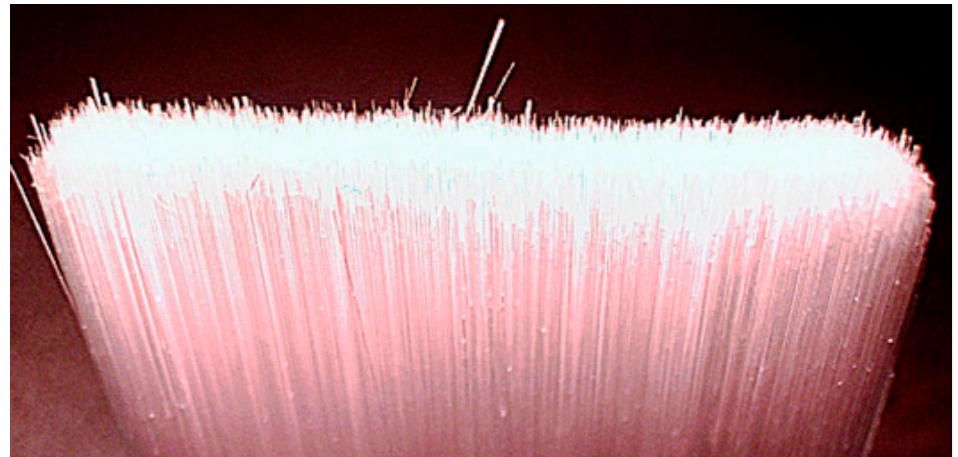
Figure 1. A bundle of sapphire fibres obtained by the method of internal crystallisation. The bundle width is 30 mm.